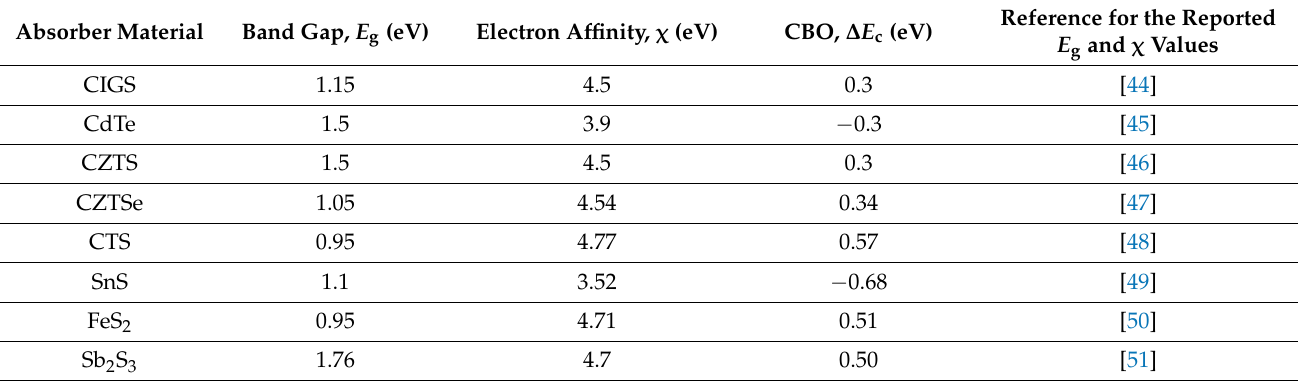
Table 5. Band gap, electron affinity and the resulting conduction band offset (CBO) values calculated using Equation (3) for a few shortlisted newly emerging and established absorber